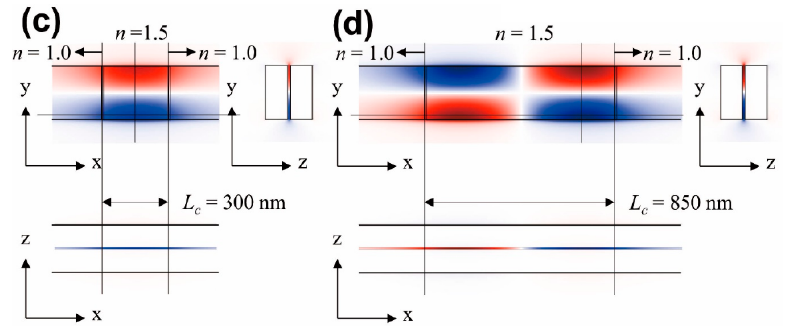
Figure 3. ( a ) Schematic of a cavity consisting of a cavity region ( n = 1.5, green color) and two mirror waveguides ( n = 1.0). Here, w = 240 nm, h = 100 nm, t = 10 nm, L m = 1000 nm, and the cavity length is L c ; ( b ) Dispersion curves of first ‐ order waveguide modes for dielectric materials (between the silver strips) with different refractive indices of n = 1.5 (blue) and n = 1.0 (red). The cutoff frequencies (wavelengths) are 2 π f = 1059 THz (1779 nm) and 1493 THz (1261 nm), respectively. The horizontal blue line indicates a frequency of 1215 THz (1550 nm). The light line is indicated by the blue line; ( c , d ) Top and side views of the electric field profiles of fundamental ( L c = 300 nm) and second ‐ order ( L c = 850 nm) cavity modes.